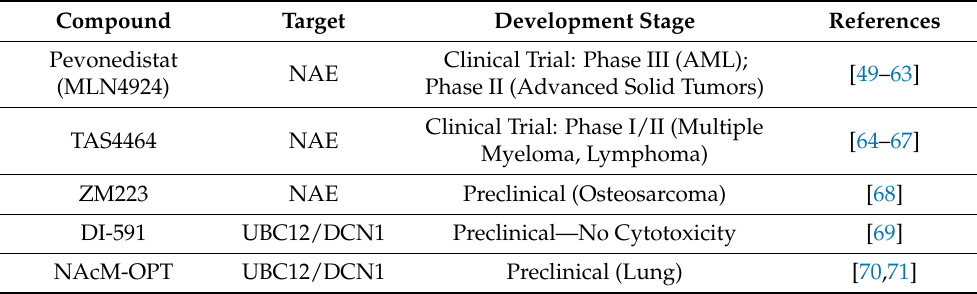
Figure 1. Representative model of the compounds which target the NEDDylation pathway. PEV, TAS4464, and ZM223 all target NAE. PEV inhibits NEDDylation by forming a covalent NEDD8-PEV adduct within the NAE active site to block enzymatic activity. DI-591 and NAcM-OPT disrupt the binding of DCN1 with UBC12, thus inhibiting the NEDDylation of a subset of Cullin-RING ligases. Abbreviations: NAE—NEDD8 activating enzyme; UBA3—Ubiquitin-like modifier activating enzyme 3; APPBP1—NEDD8 activating enzyme E1 regulatory subunit; UBC12—NEDD8 conjugating enzyme Ubc12; DCN1—Defective in Cullin NEDDylation 1; Ub—Ubiquitin; COP9—Constitutive photomorphogenesis 9; CAND1— Cullin-associated NEDD8-dissociated protein 1. Table 2. Compounds Targeting NEDDylation.